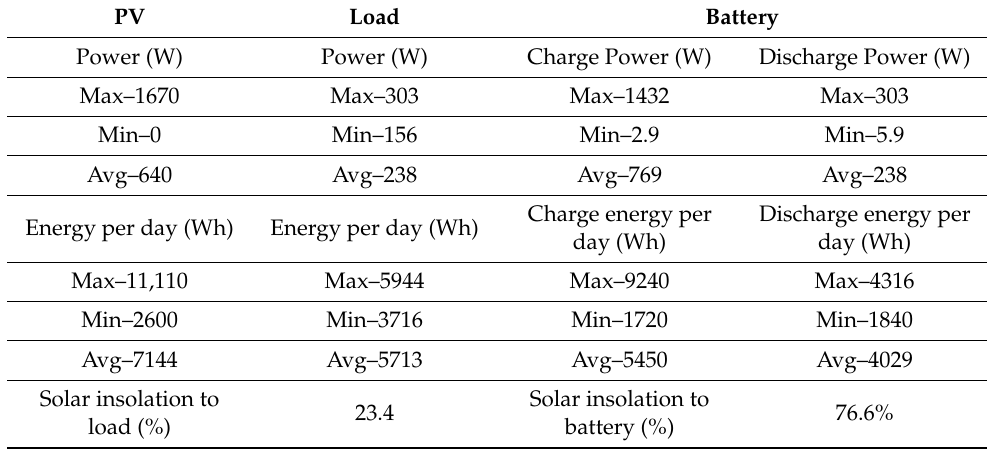
Figure 2. Seven day profile of June 2019 ( a ). Solar PV variation and load demand ( b ). Expected battery charge and discharge cycle. Table 1. Summary of June 2019 profile (no scale down, S E =